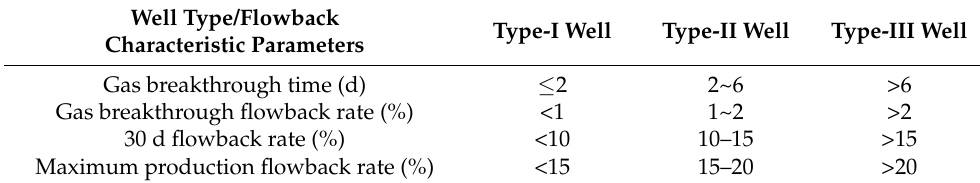
Table 4. Flowback evaluation indexes of gas wells in Changning Shale Gasfield.